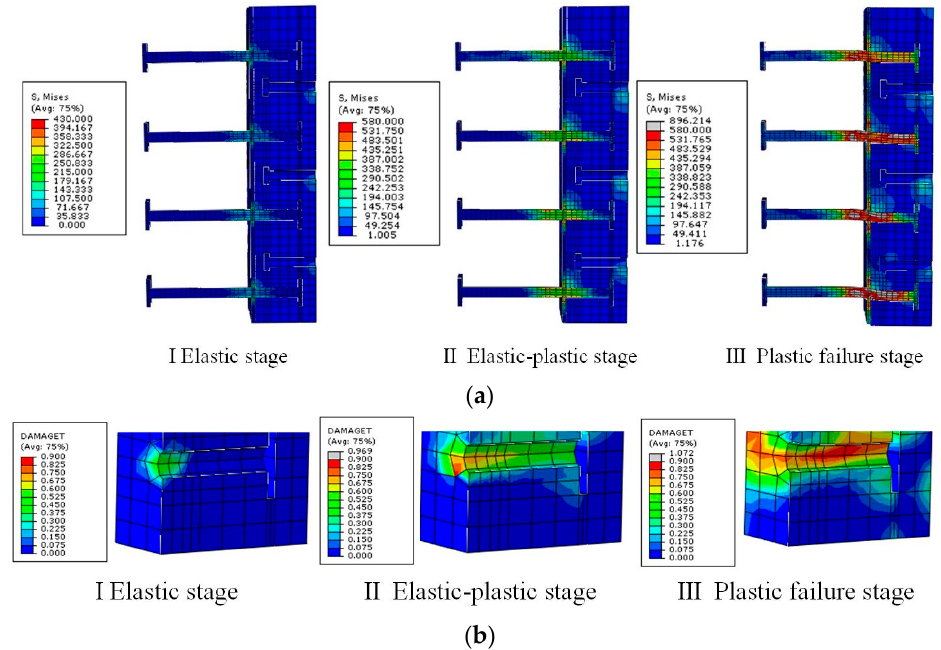
Figure 23. Variation of concrete damage and Shear reinforcement stress during the loading: ( a ) Shear reinforcement and stud; ( b ) UHPC.